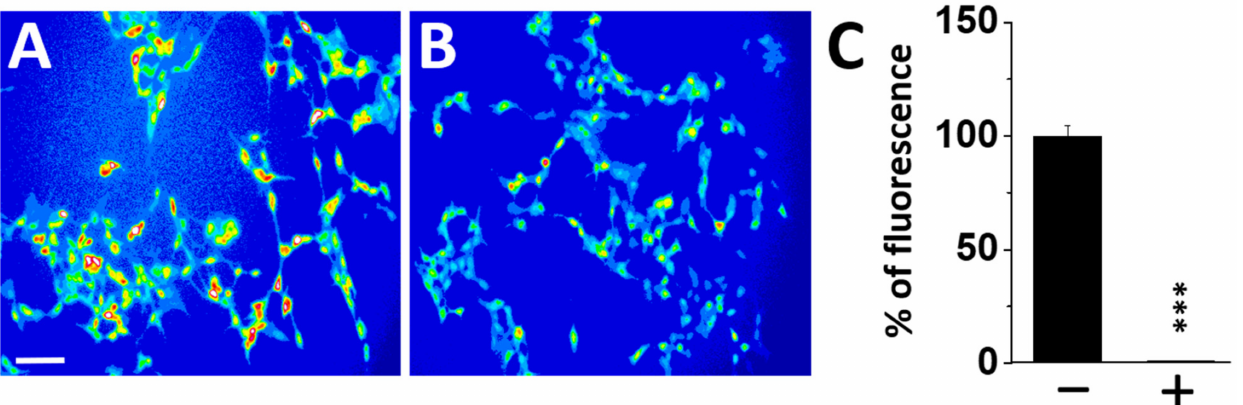
Figure 4. Protection against oligomer formation transferred by cell-free supernatants of SH-SY5Y-AmyP53 cells. Non- transfected SH-SY5Y cells were preloaded with Fluo4 AM, then incubated with A β 1–42 (220 nM) diluted in culture medium ( A ) or in cell-free cultured supernatant harvested from SH-SY5Y-AmyP53 cells ( B ). The histograms in panel C show a quantitative analysis of Ca 2+ entry in both conditions after 60 min of incubation with A β 1–42 minus ( − ) or plus (+) cell-free cultured supernatant harvested from SH-SY5Y-AmyP53 cells. Results in the histogram ( C ) are expressed as mean ± SEM. Student’s t -test was used to compare the statistical significance. *** p < 0.0005 with 42 < n < 65. The pictures are representative of three independent experiments, scale bar: 100 µ